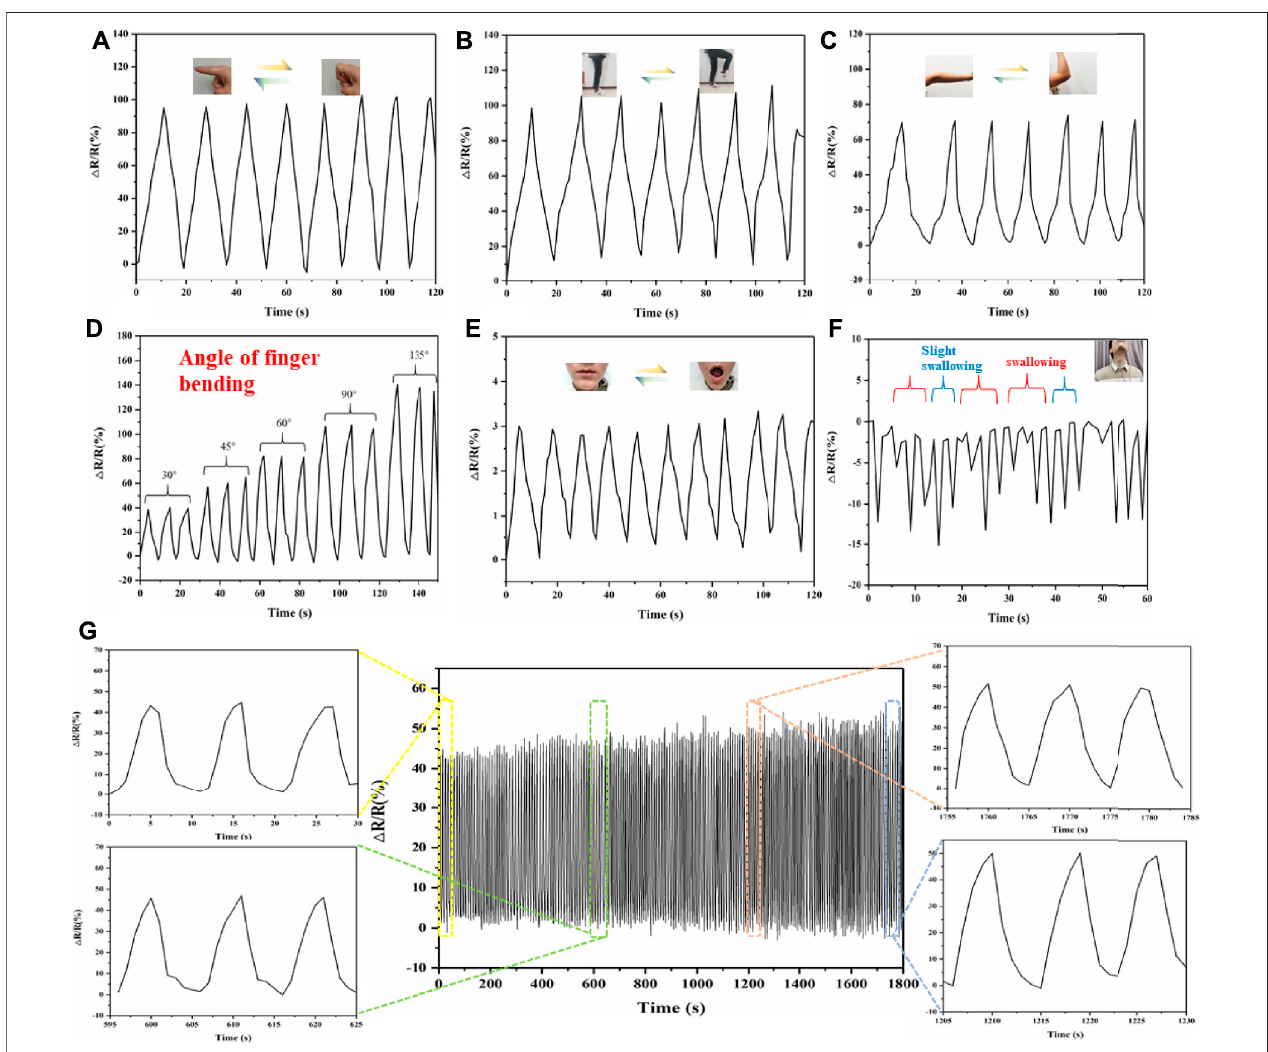
FIGURE 4 | Application of HC-KG hydrogel as a fl exible strain sensor to detect various human motions. Real-time monitoring of large human motions, such as the bending of fi nger (A) , elbow (B) , and knee (C) . (D) HC-KG hydrogel showed different relative resistance change for fi nger bending at different angles. Real-time monitoringofhumanmicromotions,suchastheopeningandclosingofmouth (E) andswallowingwithdifferentintensity (F) . (G) RelativeresistancechangeoftheHC-KG hydrogel – based strain sensor under cyclic tensile from 0 to 20% for 30 min.